Question: Describe this figure in one sentence.
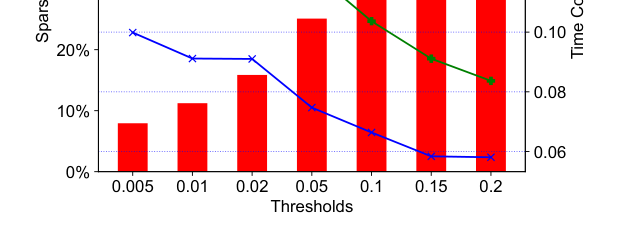
Answer: Variation of sparsity and the ability to keep sensitive information under different thresholds. Images are tested in the latent space. The red bars denotes to the percentage represented sparsity. The blue line and the green line are the cosine similarity between the remained image (encrypted part), the removed part and the original image, respectively.